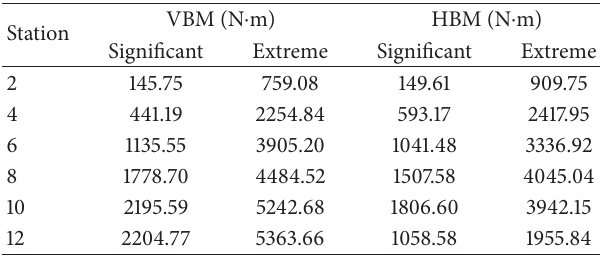
Table 3: Statistical results of load responses.